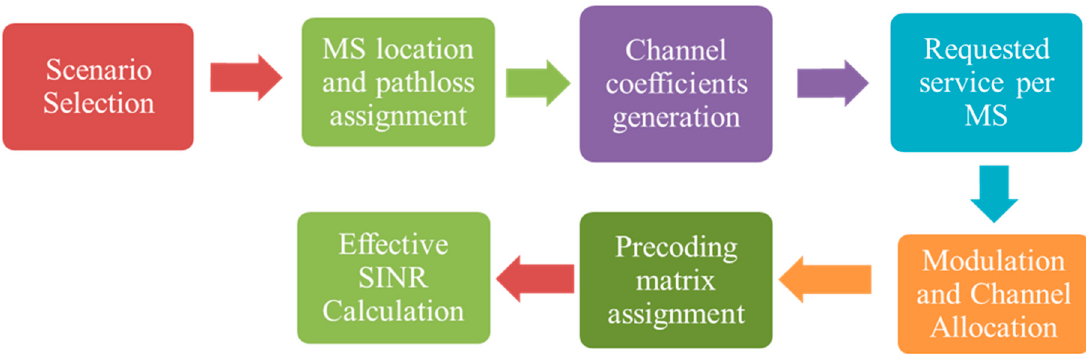
Figure 4. Cellular network simulation per channel drop.